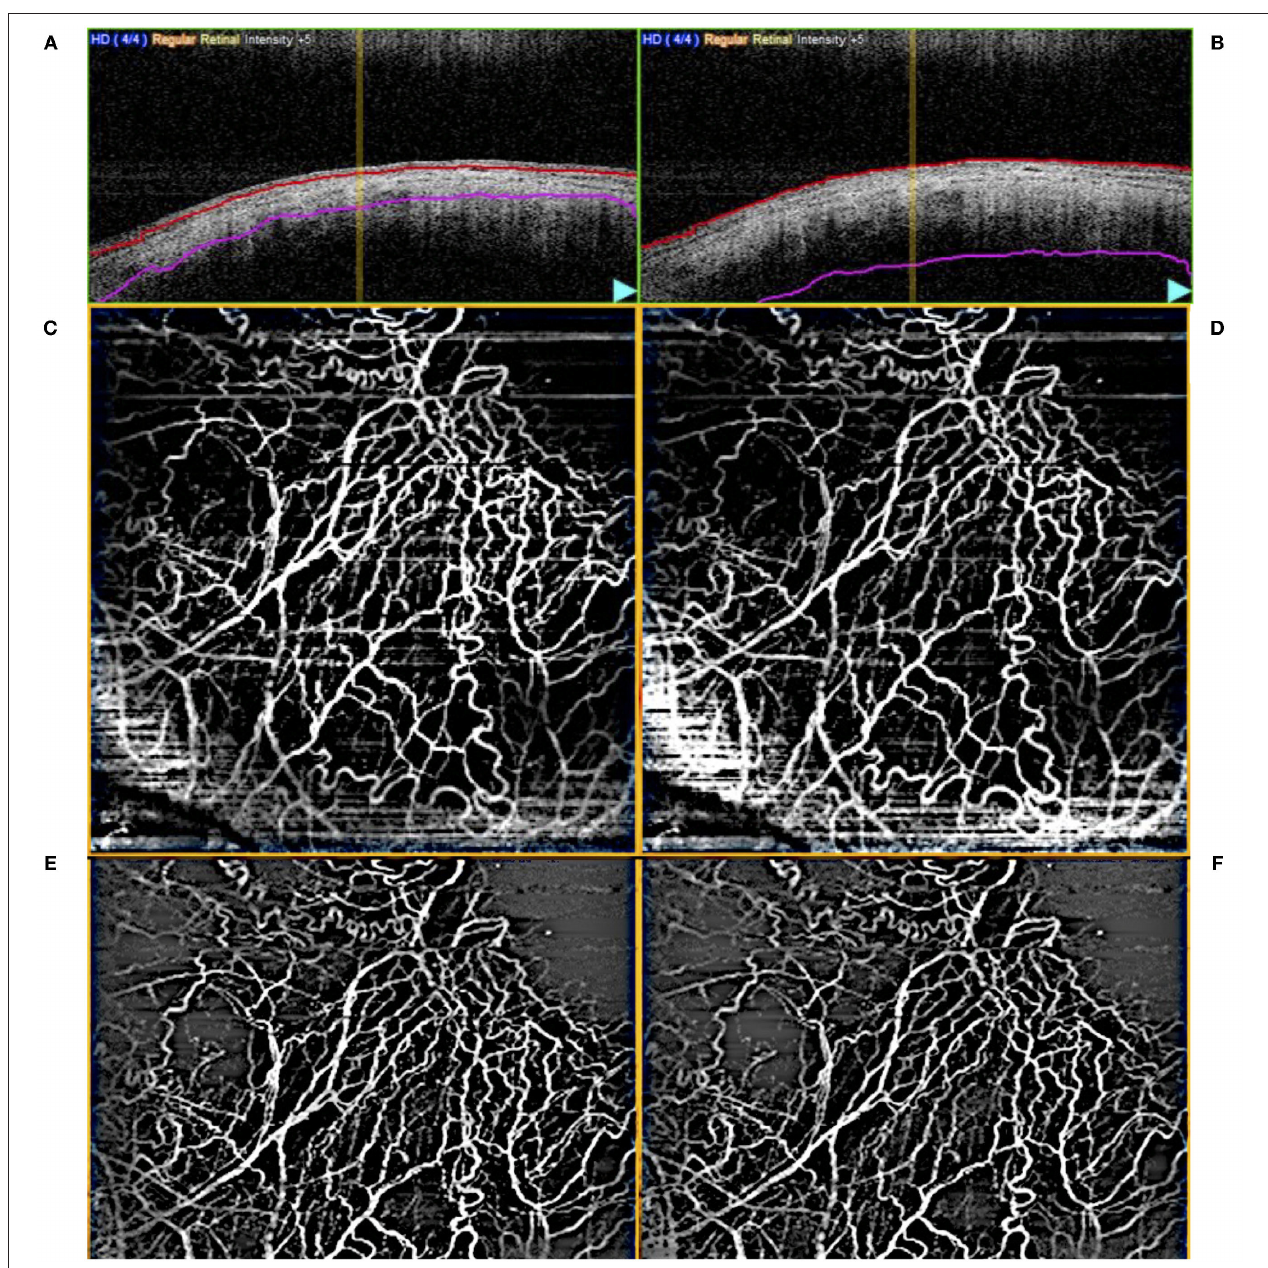
FIGURE 2 | Example of (A) episcleral and (B) full layer (conjunctival, episcleral, scleral) segmented optical coherence tomography angiography (AS-OCTA) images. Unprocessed en face AS-OCTA images of the (C) episcleral and (D) full layer vasculature, respectively, and after removal of artefacts [ (E,F) ,